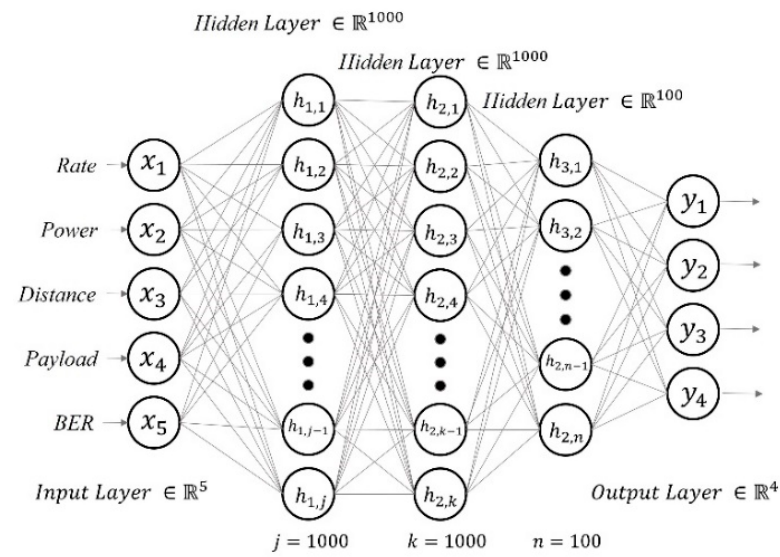
Figure 7. The MLP model structure.